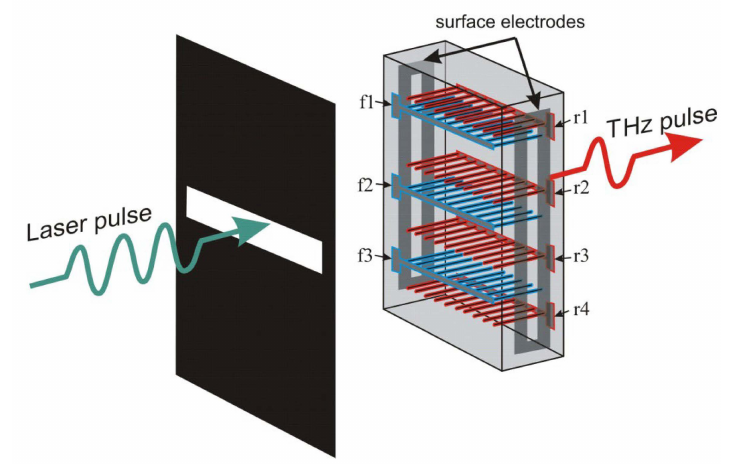
Figure 1. A schematic of graphite buried electrodes formed inside diamond